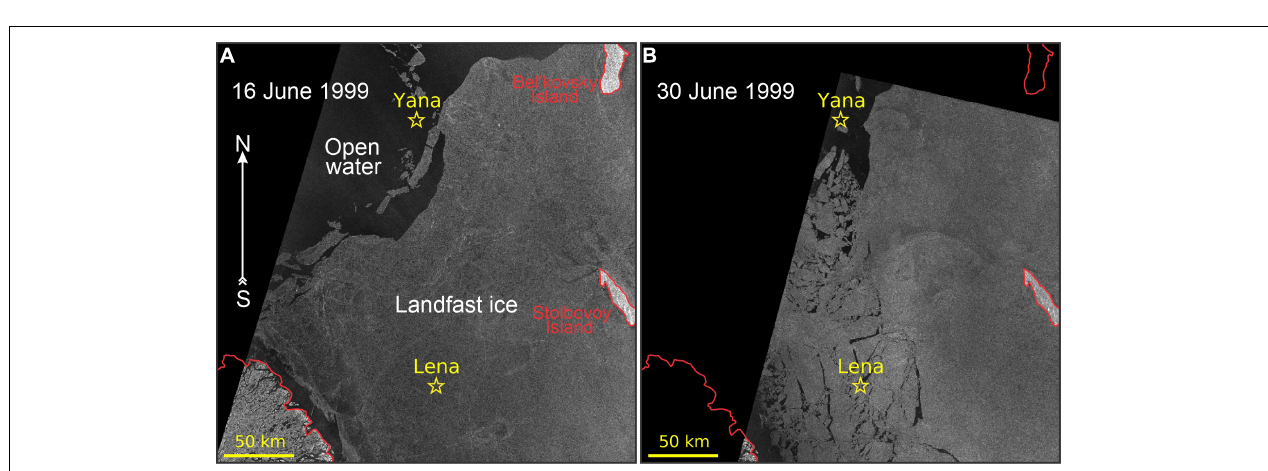
FIGURE 7 | RADARSAT-1 ScanSAR satellite images show the evolution of ice conditions in the Laptev Sea during June 1999: (A) 16 June 1999 and (B) 30 June 1999. Black areas are associated with open water. All other designations are similar to those in Figure 5 . © CSA (1999).